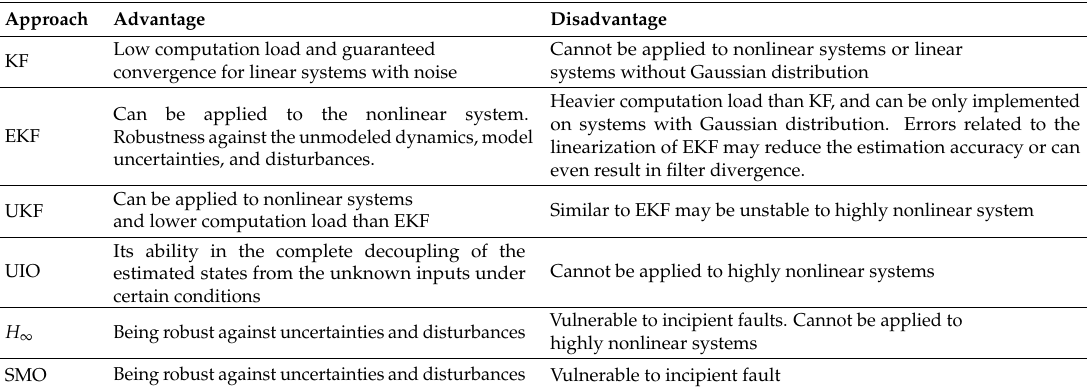
Table 1. Summarizing the advantages and disadvantages of the model-based FDI